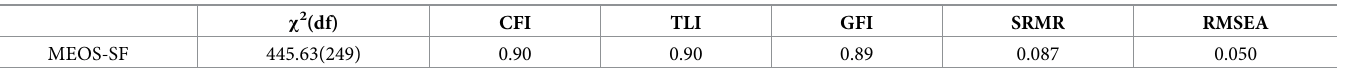
Table 5. CFA model fit indices of